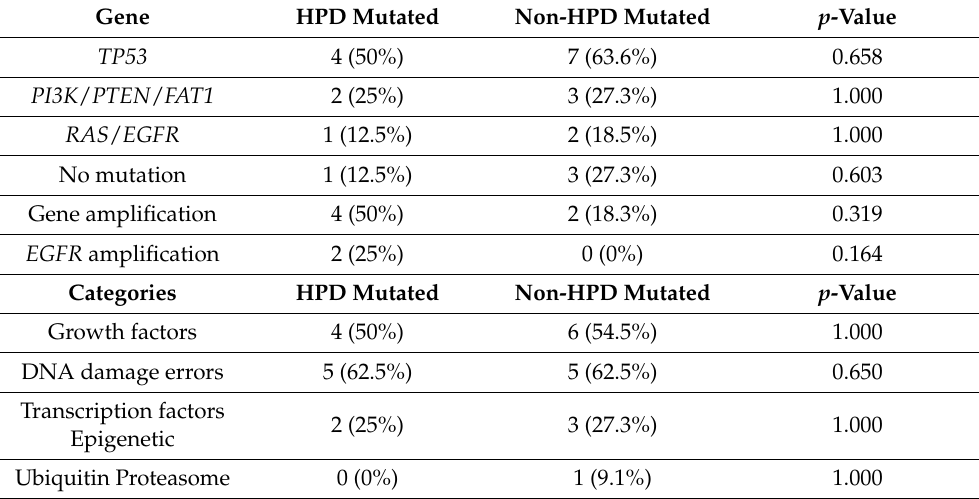
Table 2. Genomic alterations in hyperprogressors vs. in non